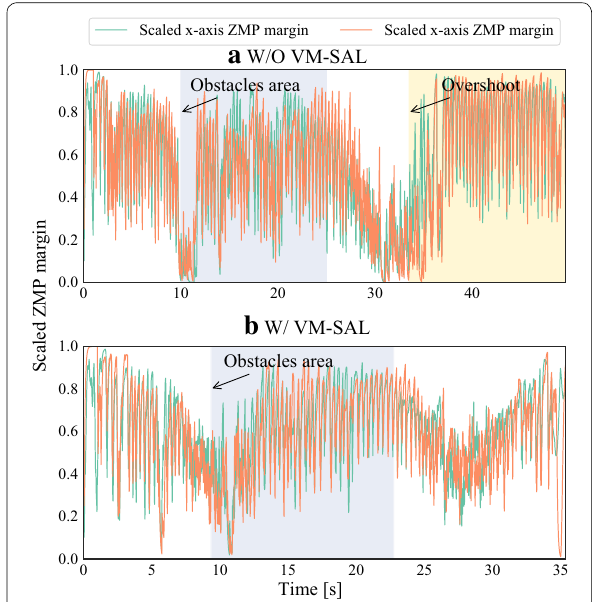
Fig. 9 ZMP margin scaled by the maximum distance to the edge of the support polygons a when stepping into the obstacle area, the robot was disturbed by the obstacles, and ZMP was instantaneously on the edge of the support polygons; b the robot succeeded to keep